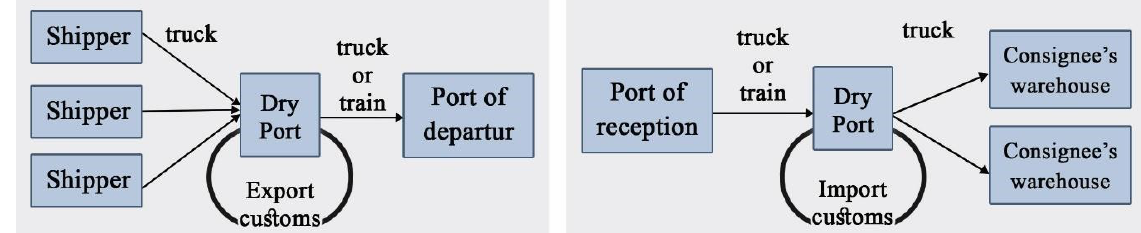
Figure 5. The procedures and services in terminals and dry